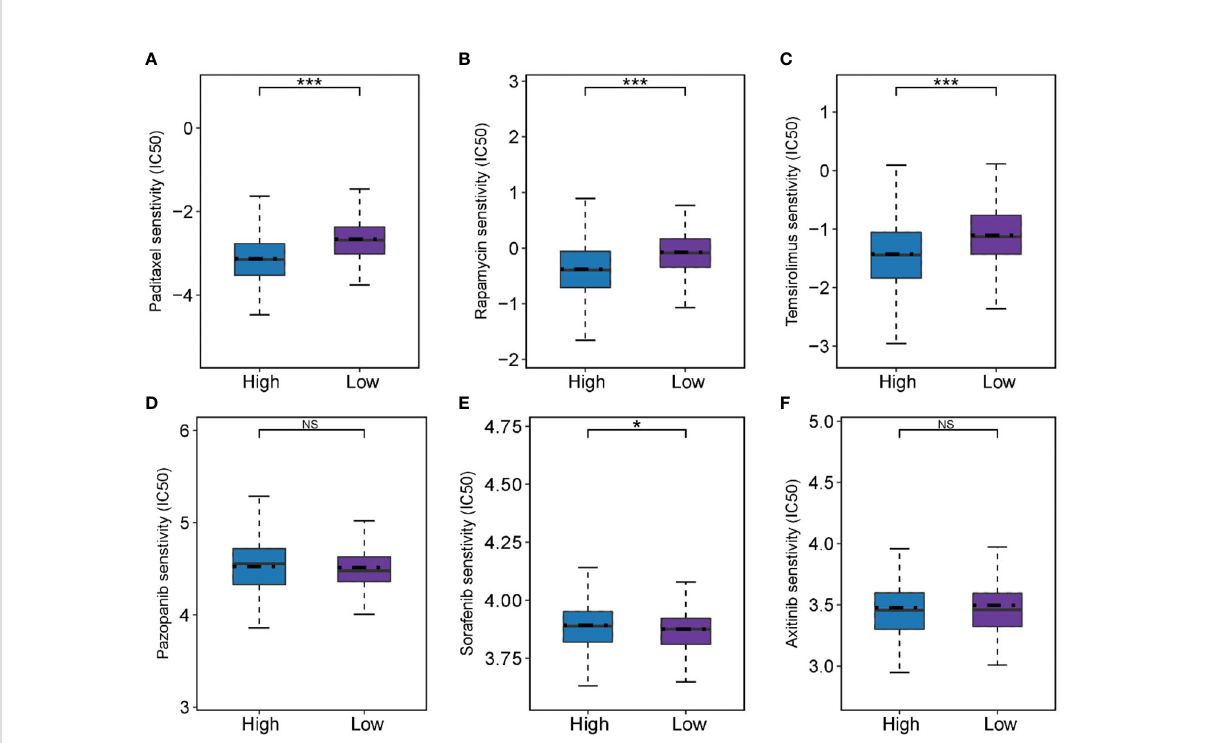
FIGURE 8 Predictive results of chemotherapeutic responses. (A-F) The differences of chemotherapeutic response in the high- and low-FMI group. * P < 0.05; *** P